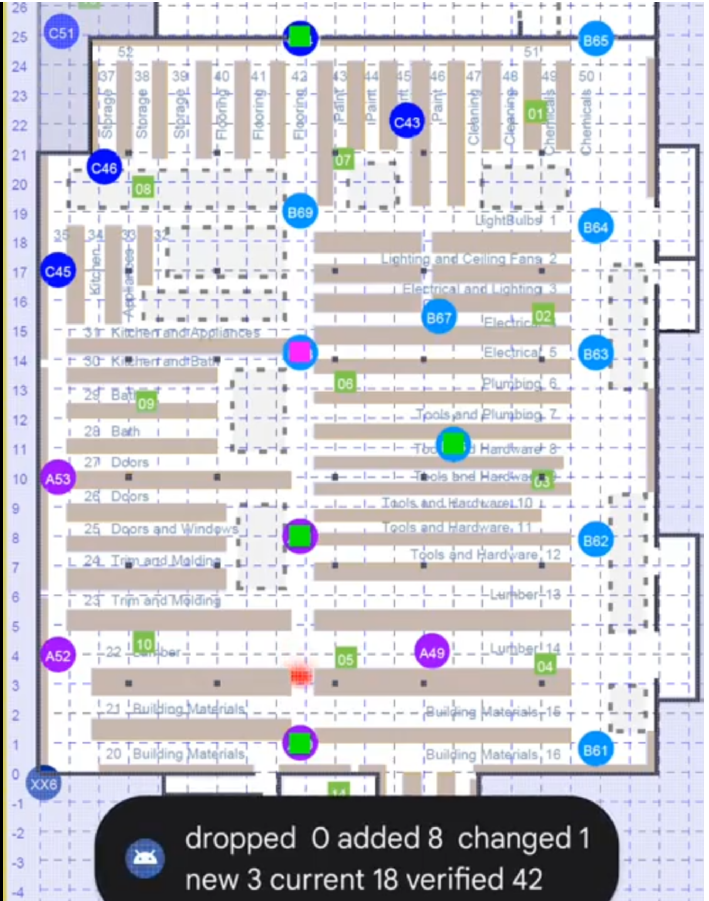
Figure 7. Screenshot of the FTMRTT application using Bayesian grid update method as a “heat map”. The “hot spot” (red) is the area of high probability. APs currently responding to ranging requests are shown as green squares. APs in the current selection not responding are shown as magenta squares. The cells in the Bayesian grid here are 0.5 m on a side. The Bayesian grid update method uses the observation model developed